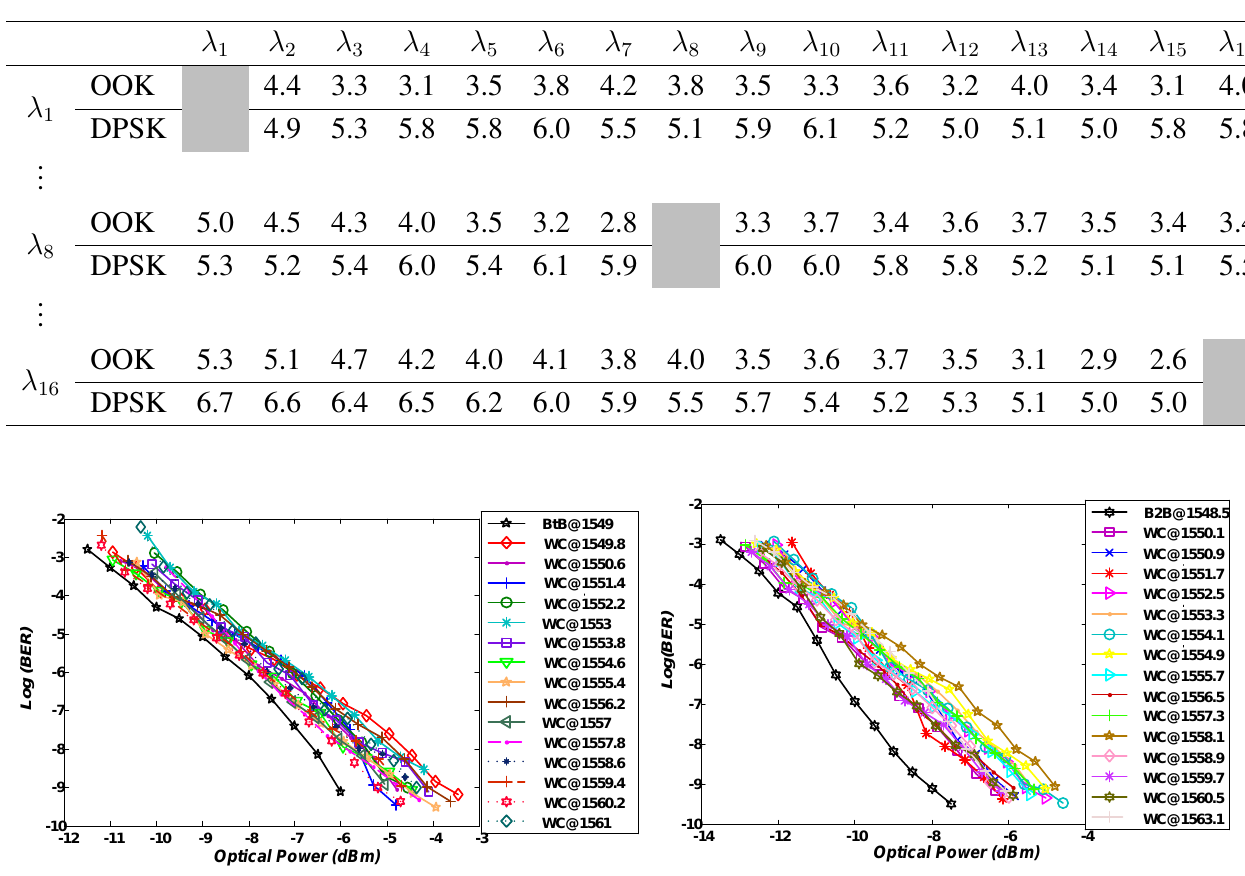
Table 1. Absolute value of conversion efficiency.